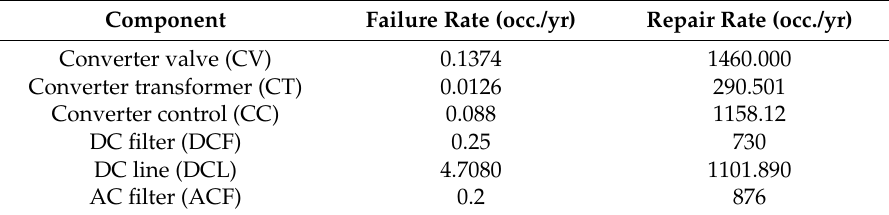
Table 1. Reliability parameters of UHVDC transmission